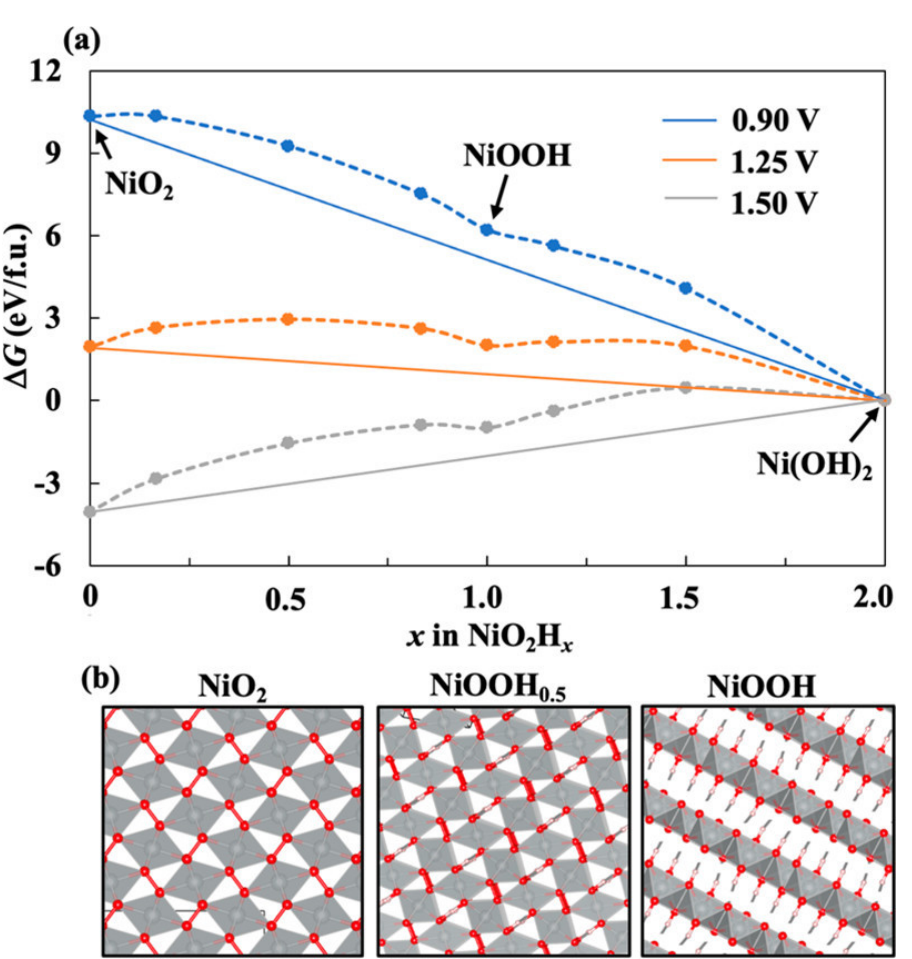
Figure 35. ( a ) Convex hull diagram of NiO 2 H x at U = 0.90, 1.25, and 1.50 V vs. RHE. ( b ) Global minima of NiO 2 , NiOOH 0.5 , and NiOOH. Red balls—O; gray balls—Ni; white balls—H. The dashed lines in ( b ) represent the hydrogen bonds. (Reprinted from ref. [210] with permission from the Journal of Journal of Physical Chemistry C. Copyright © 2021, American Chemical Society).